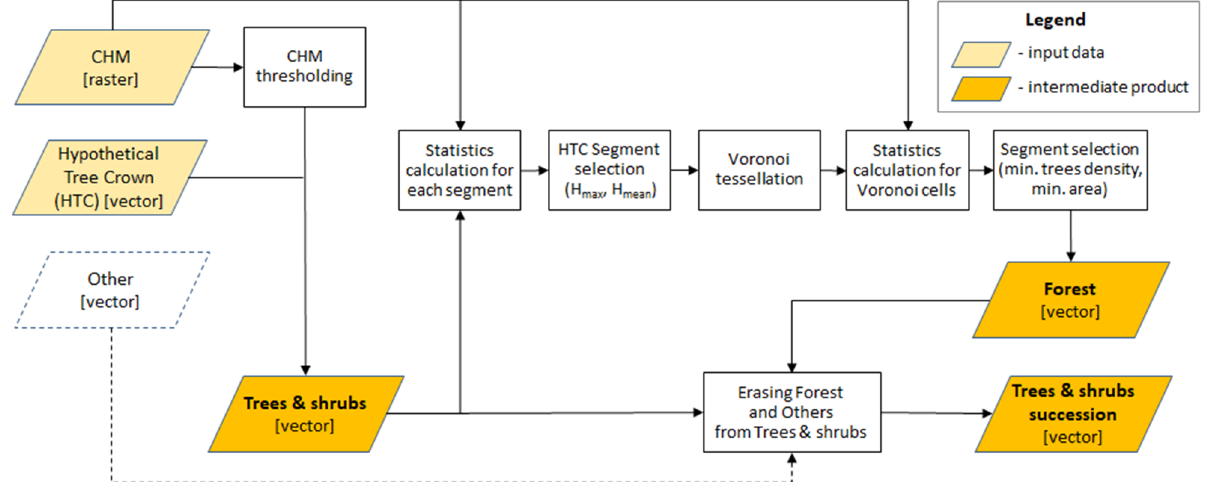
Figure 3. Scheme of Step 2—determining the spatial extent of the potential succession of trees and shrubs.